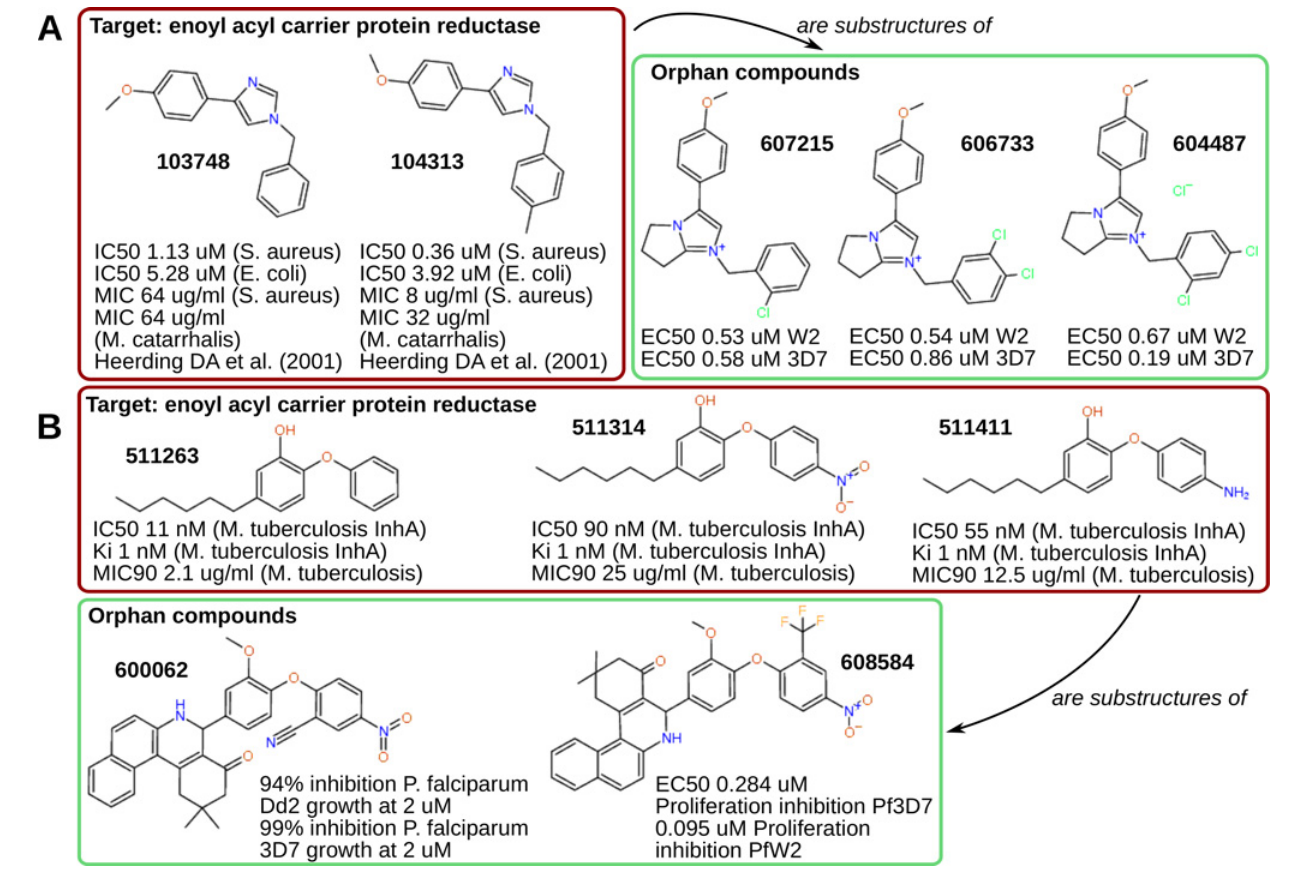
Fig 8. Suggesting targets for orphan compounds: enoyl-acyl carrier protein reductase. Two groups of orphan compounds (panels A, B) with structurally different scaffolds are linked to inhibition of enoyl-acyl carrier protein reductases.